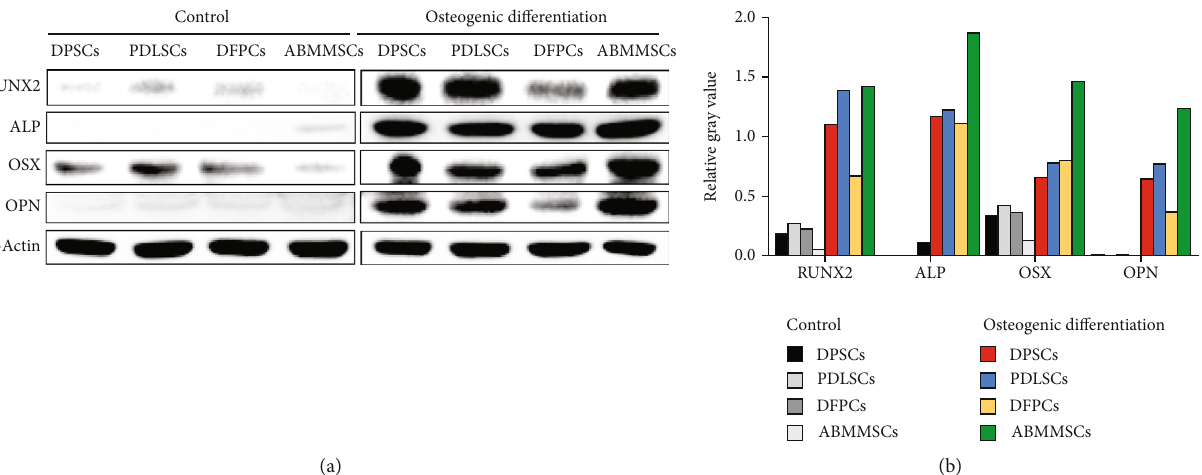
Figure 5: Protein expression for osteogenic di ff erentiation. (a) Western blot analysis of osteogenic markers (RUNX2, ALP, OSX, and OPN) proteins in DPSCs, PDLSCs, DFPCs, and ABMMSCs with and without 21 days of osteogenic di ff erentiation ( n = 3 ). (b) The relative gray value of RUNX2, ALP, OSX, and OPN/ β -actin.